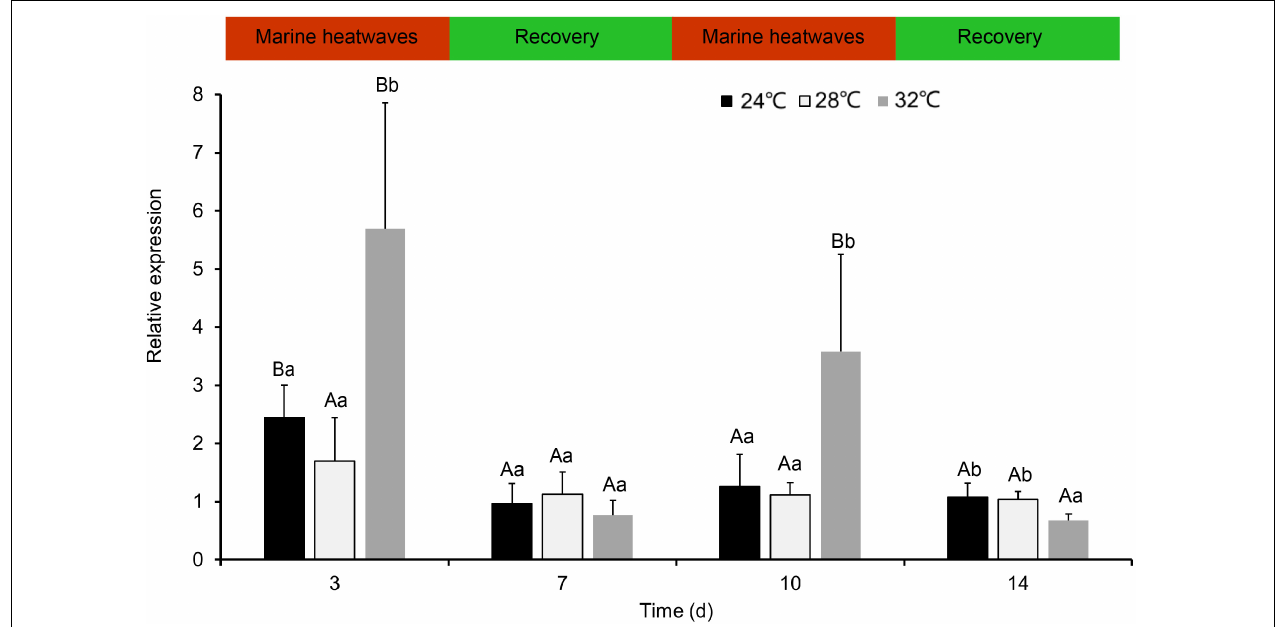
FIGURE 7 | The expression levels of PmHSP70 mRNA in gill from P. maxima after exposed to repeatedly occurring MHWs scenarios. Small letters indicate significant differences between four temperature levels within each time, and capital letters indicate significant difference between different time within each temperature treatment ( P <